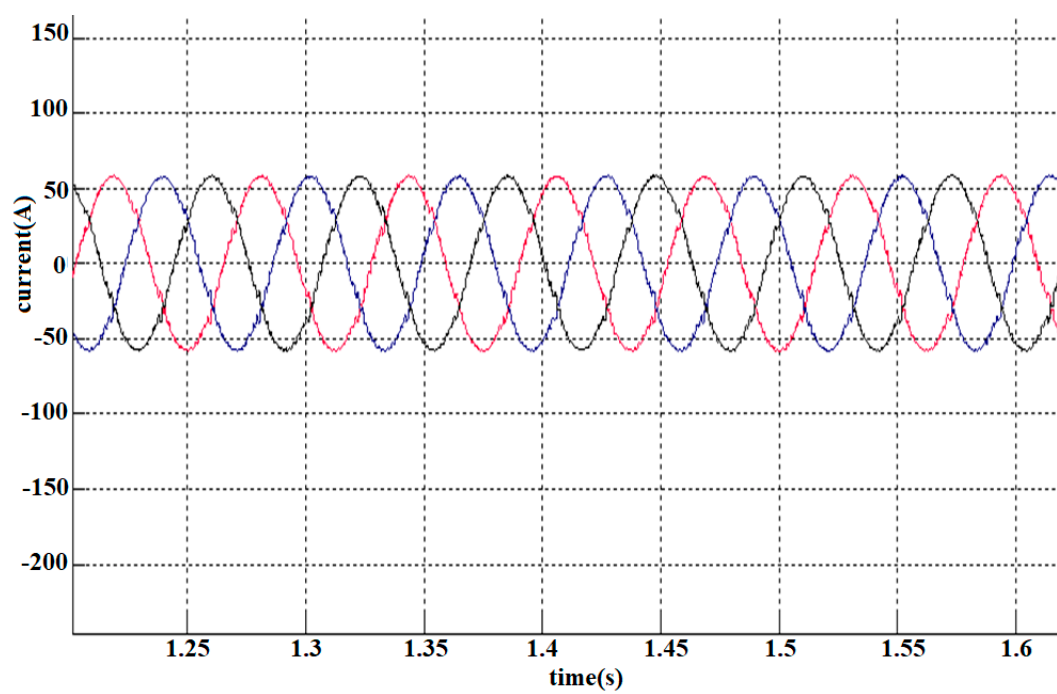
Figure 34. Current waveform across the node.